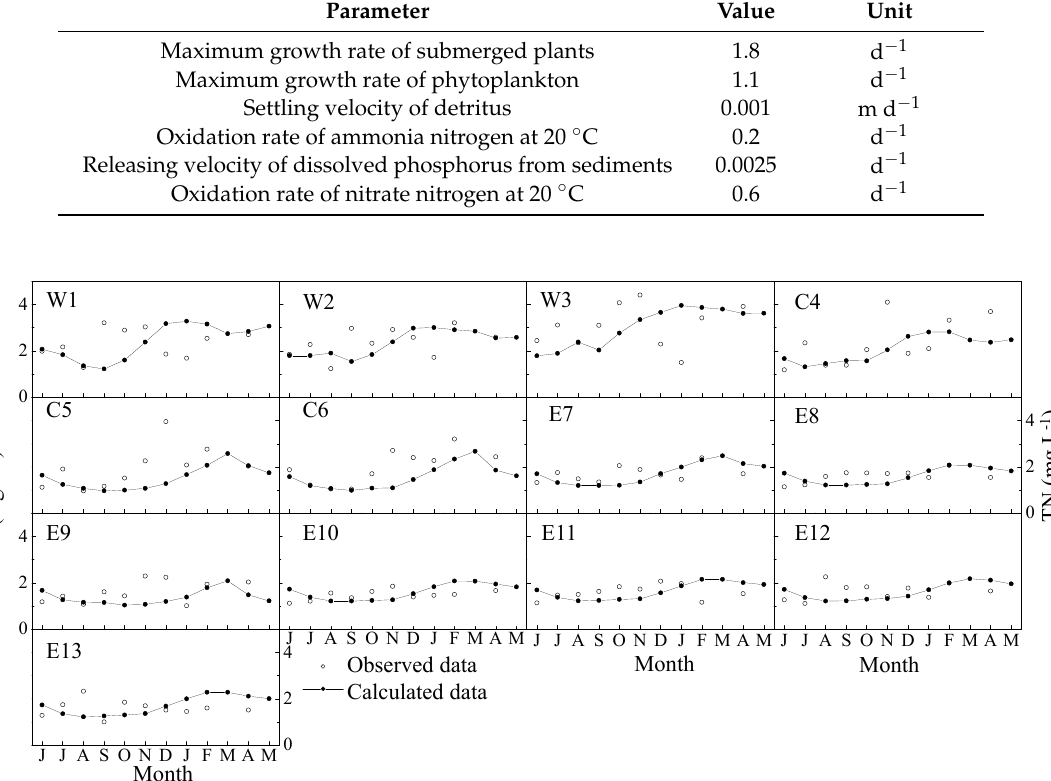
Figure 5. BP (mg L − 1 ) model (line + dots) and observed data (open dots) at 7 sites for June 2015 to May 2016.